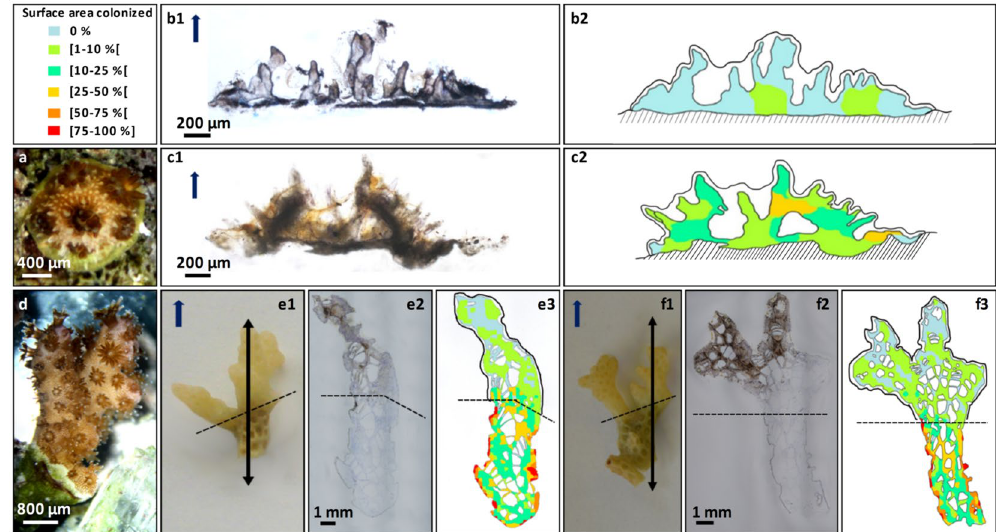
Figure 3. Colonization dynamics of skeletons of coral recruits and adult colonies by microborers. ( a ) One month old P. damicornis recruit. (b1) Thin section and (b2) corresponding distribution/abundance mapping of microborers in one month old recruit settled on non-carbonate (plastic) or ( c1 , c2 ) carbonate substrate (dead Porites skeleton). ( d , e1, f1) Adult P. damicornis colony branch. (e2) Thin section and (e3) corresponding distribution/abundance mapping of microborers in an adult colony; (f2, f3) also illustrated for another adult sample. The higher is the abundance, the warmer is the color code on maps. Dotted line represents the boundary between tissue-covered skeleton (apex) and dead skeletal base. Orientation of thin sections is parallel to coral vertical growth axis (dark blue